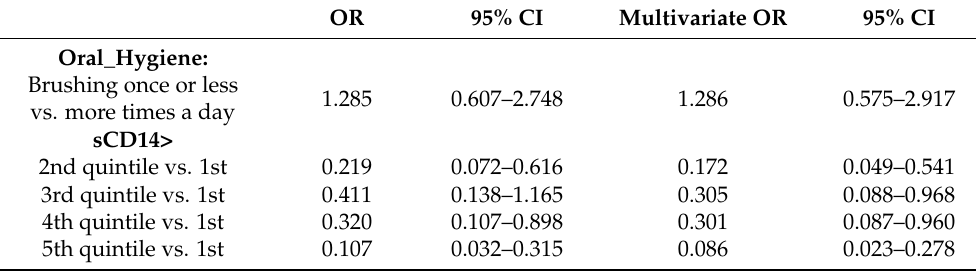
Table 3. Unconditional logistic regression univariate and multivariate (adjusted for sex and age) ORs with 95%